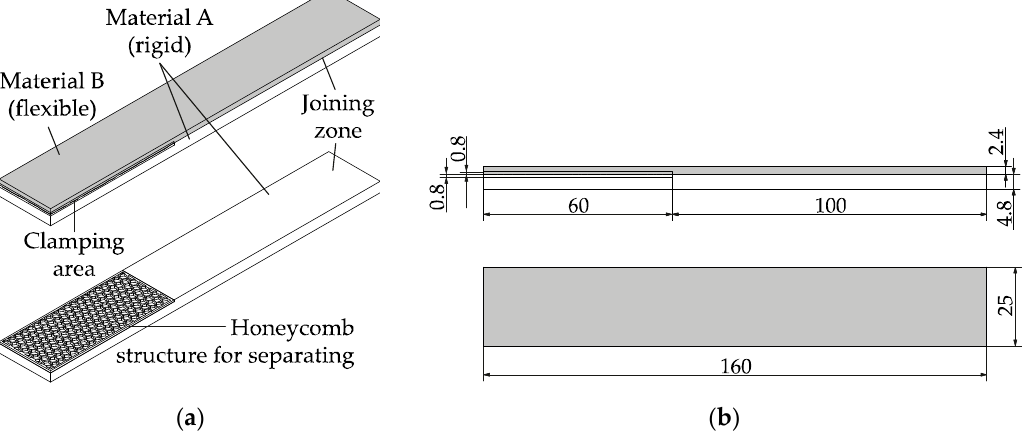
Figure 4. ( a ) Isometric view and ( b ) size specifications of the utilized test specimen.